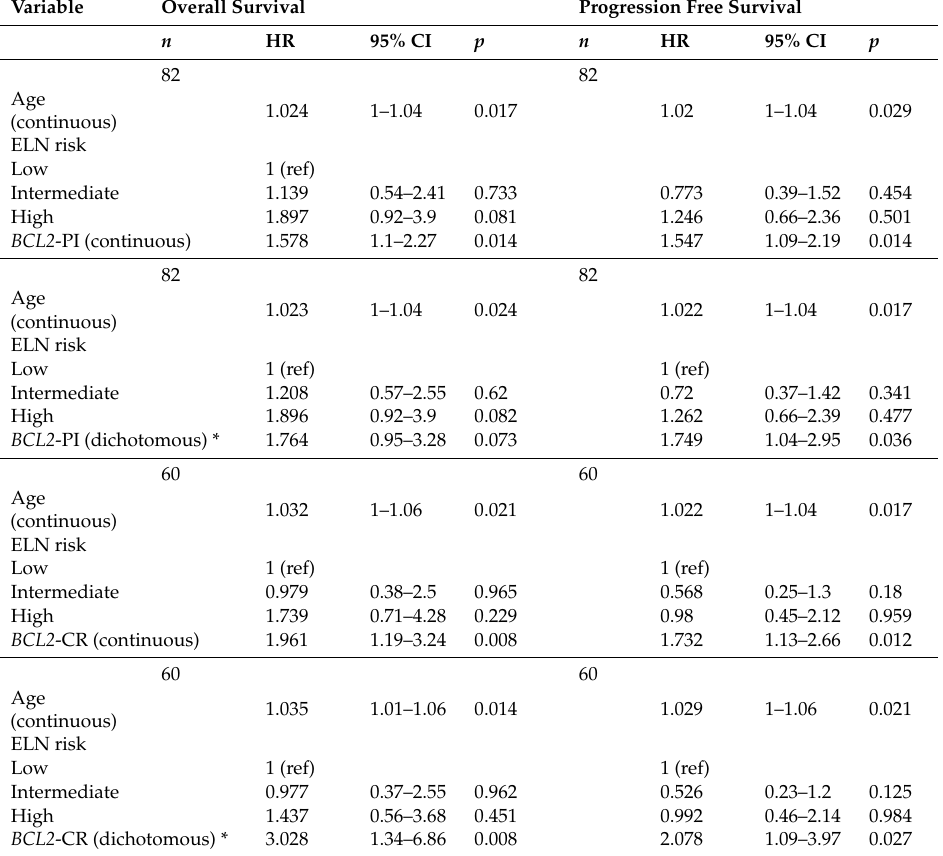
Table 2. Multivariate survival